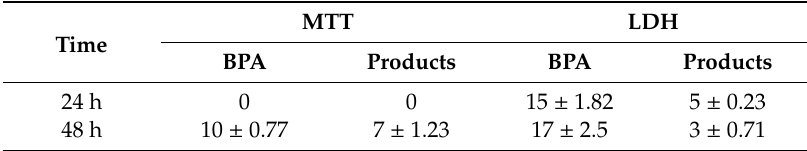
Table 6. Cytotoxicity e ff ect of BPA and its transformation products after 24 and 48 h of incubation with human colon cells evaluated using MTT and LDH tests and expressed as % of damaged cells. Time